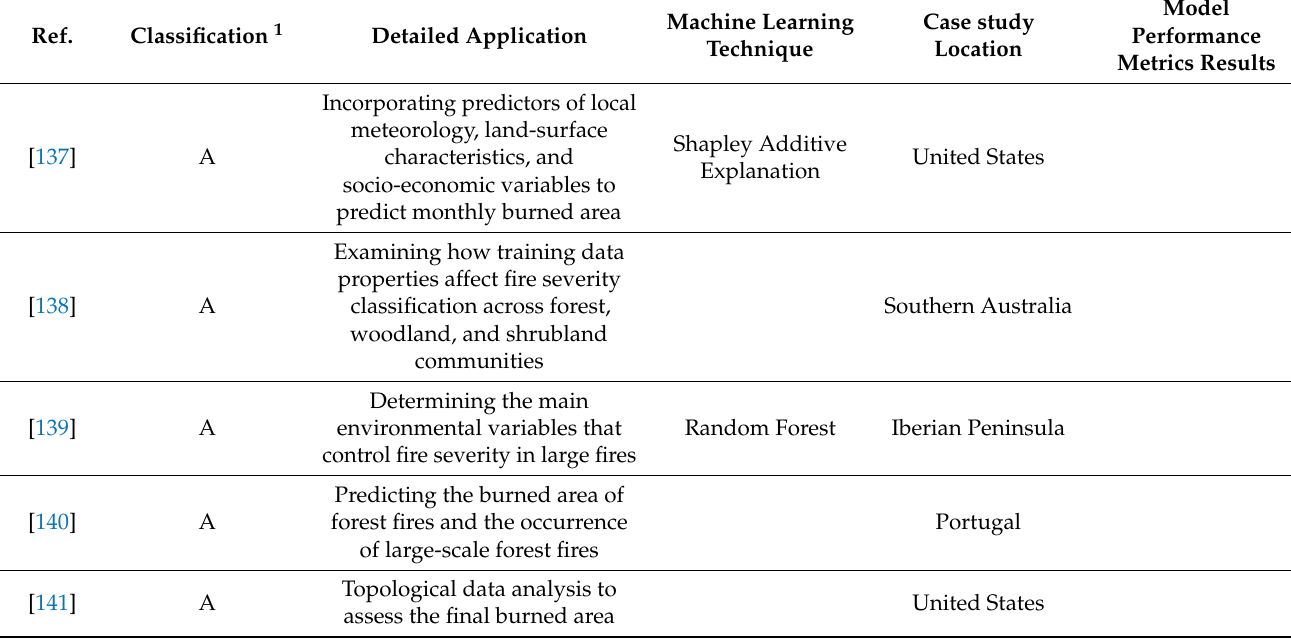
Table 4. Results: post-wildfire and restoration.